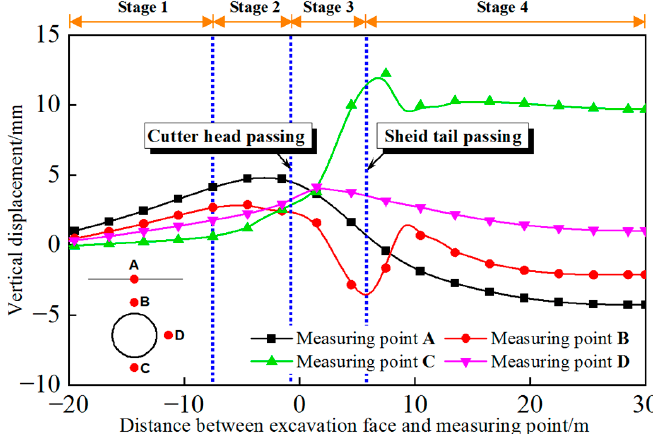
Figure 11. Settlement development curves at monitoring points.